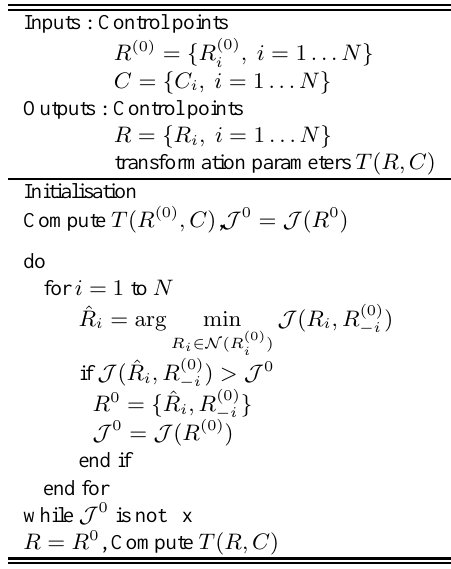
Table 1: Greedy algorithm for edge point matching refinement